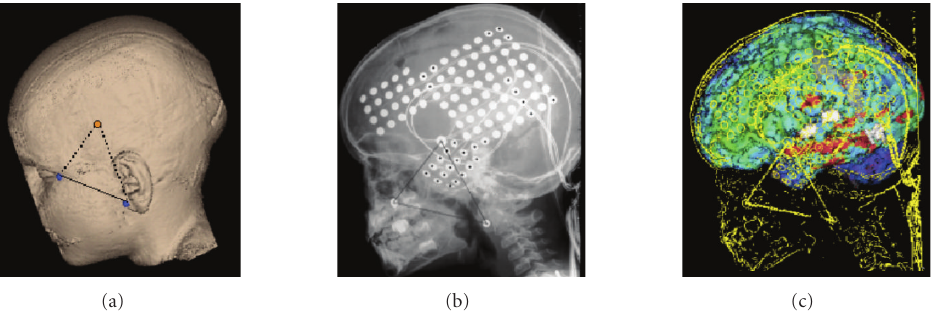
Figure 3: (a) Anatomical information is used to define virtual markers corresponding to (b) fiducial markers placed on the patients’s head prior to X-ray imaging. (c) The result is a surface view where the location of the four corner electrodes of each of the three EEG grids can be determined on the brain